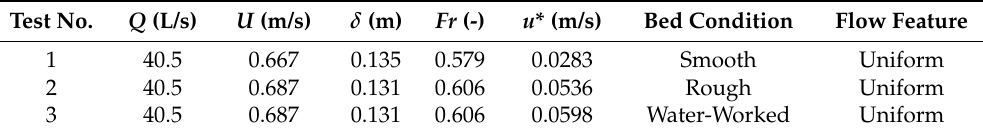
Table 1. Summary of basic experimental hydraulic and geometric conditions in smooth, rough and water-worked bed flows †